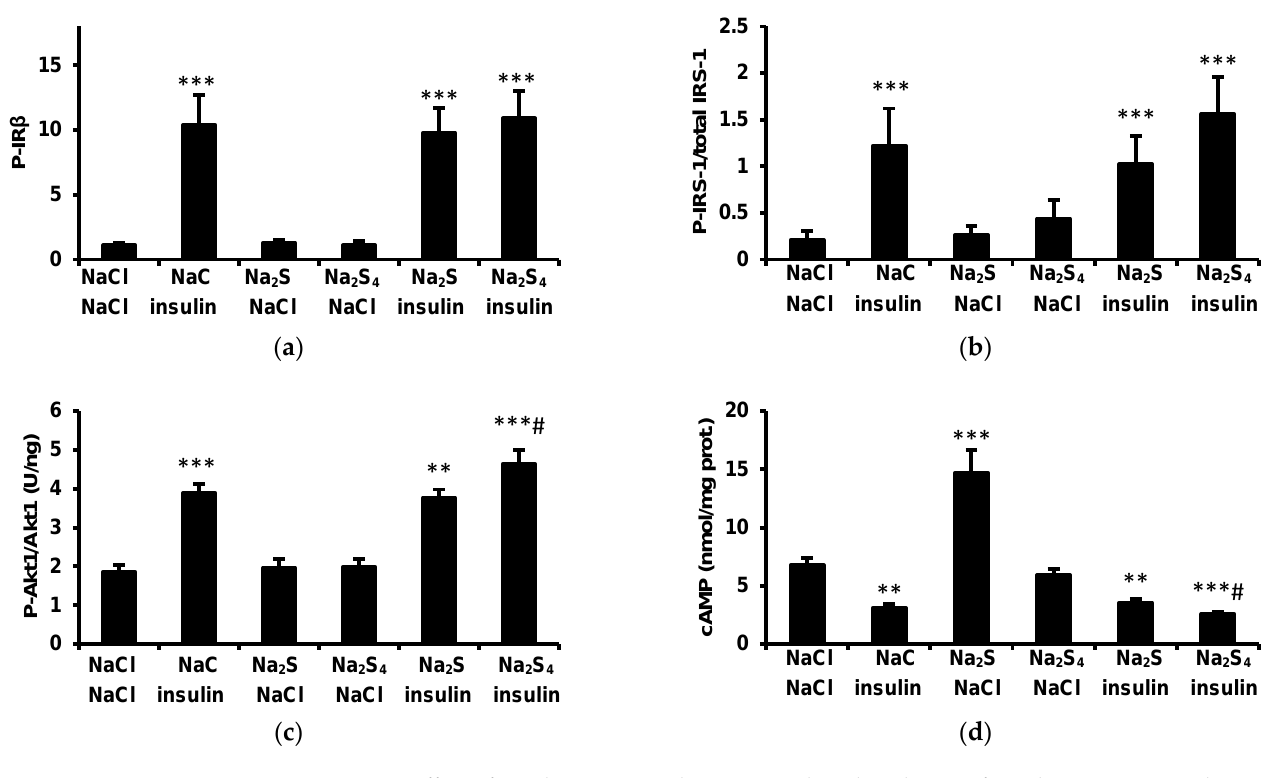
Figure 4. Effect of insulin, Na 2 S, and Na 2 S 4 on phosphorylation of insulin receptor β -subunit ( a ), phosphorylation of IRS-1 ( b ), Akt1 phosphorylation at Ser 473 ( c ), and cAMP in the adipose tissue ( d ) in vivo. NaCl (control), Na 2 S (100 µ mol/kg), or Na 2 S 4 (100 µ mol/kg) were administered iv. 15 min before insulin (0.5 U/kg ip.). Samples of mesenteric adipose tissue were collected 30 min after insulin injection. ** p < 0.01, *** p < 0.001 vs. control group receiving only NaCl, # p < 0.05 vs. group receiving only